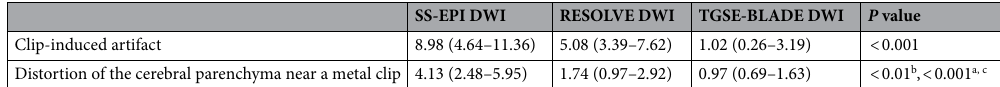
SS-EPI DWI RESOLVE DWI TGSE-BLADE DWI P